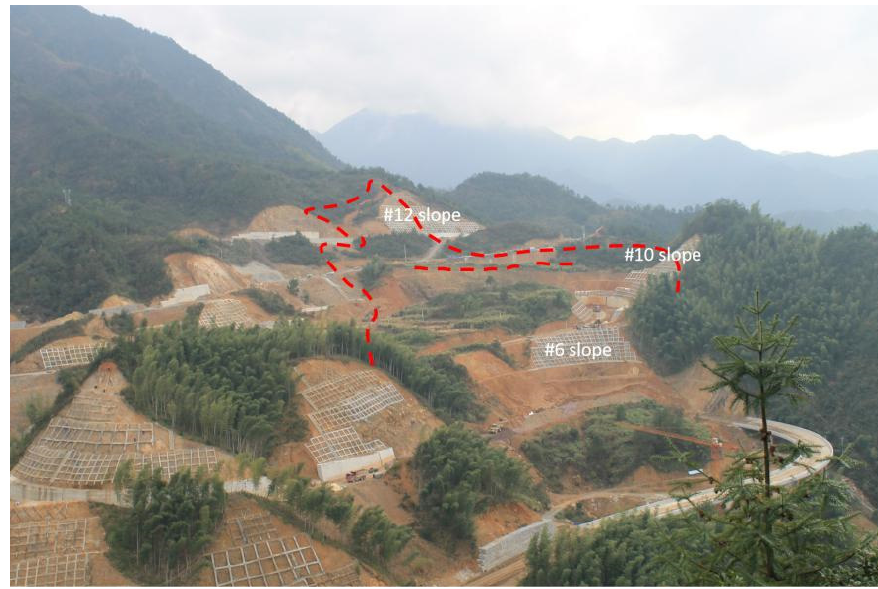
Figure 3. Overview of the project site.